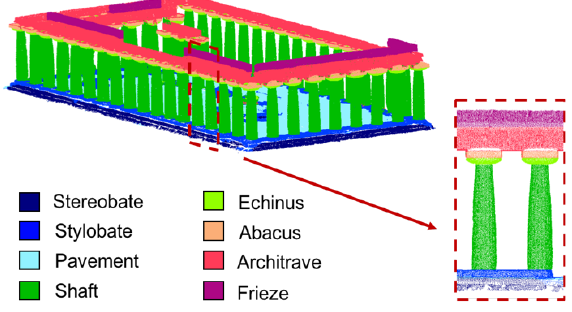
Figure 5. Classification result of the Basilica point cloud.